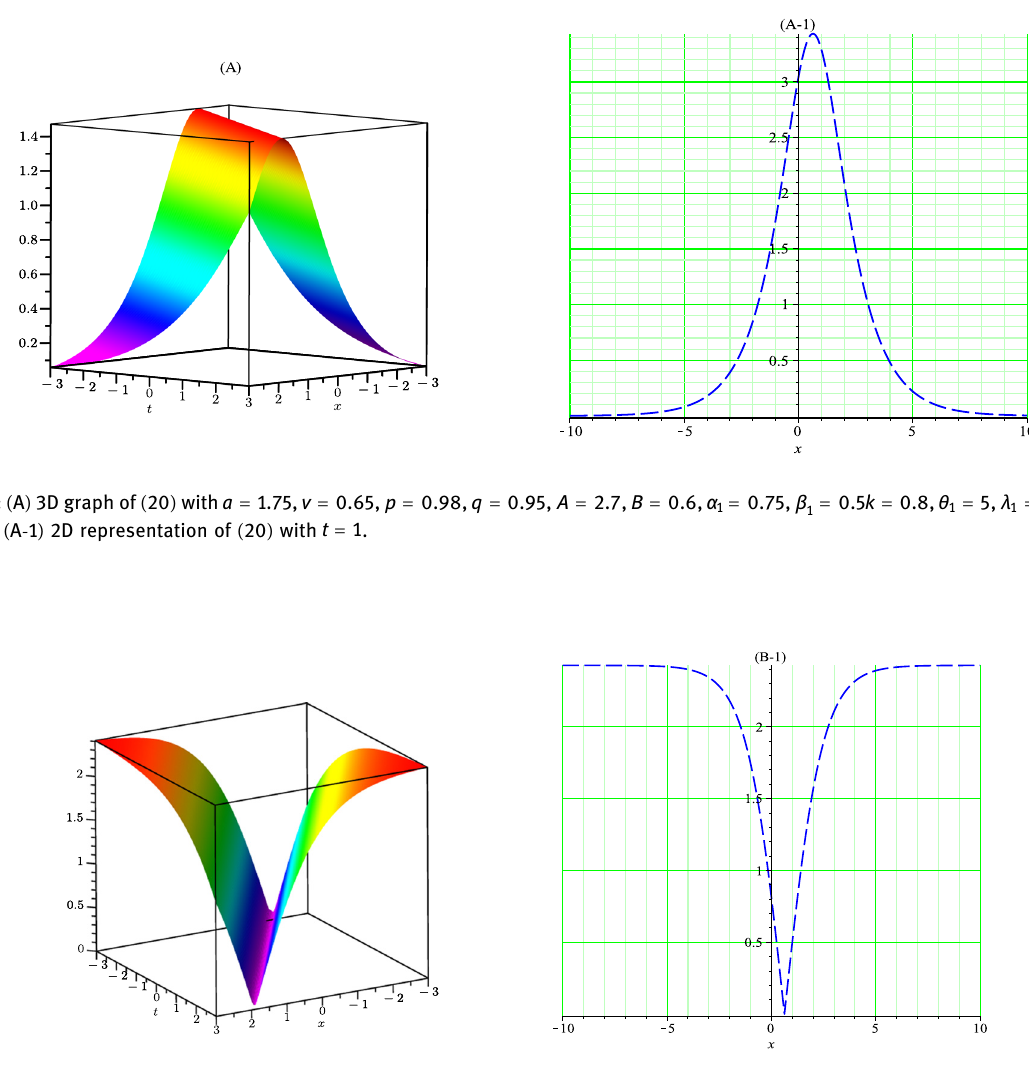
Figure 2: ( B ) 3D graph of ( 28 ) with a